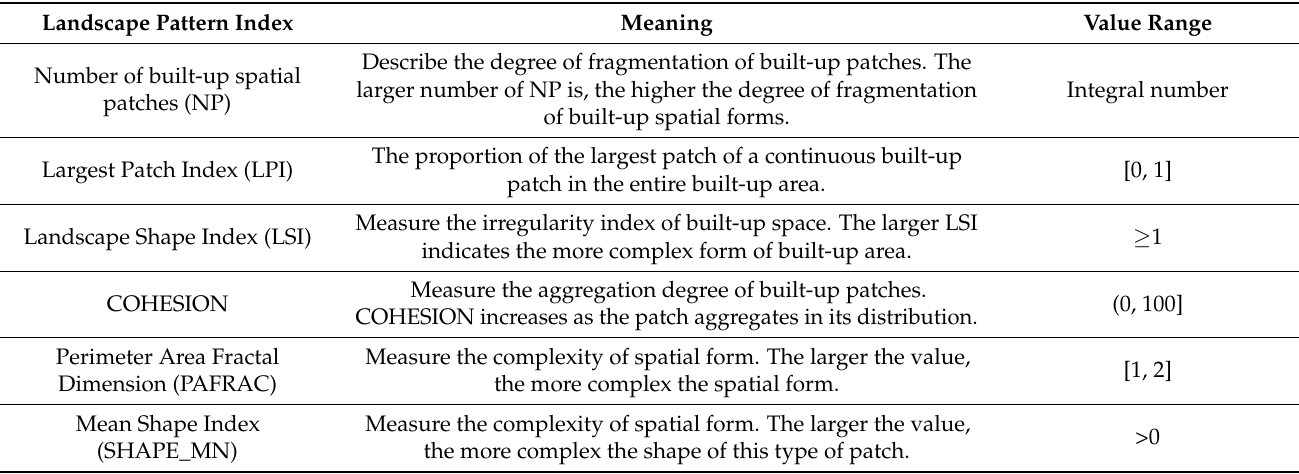
Table 2. Landscape pattern indicators and